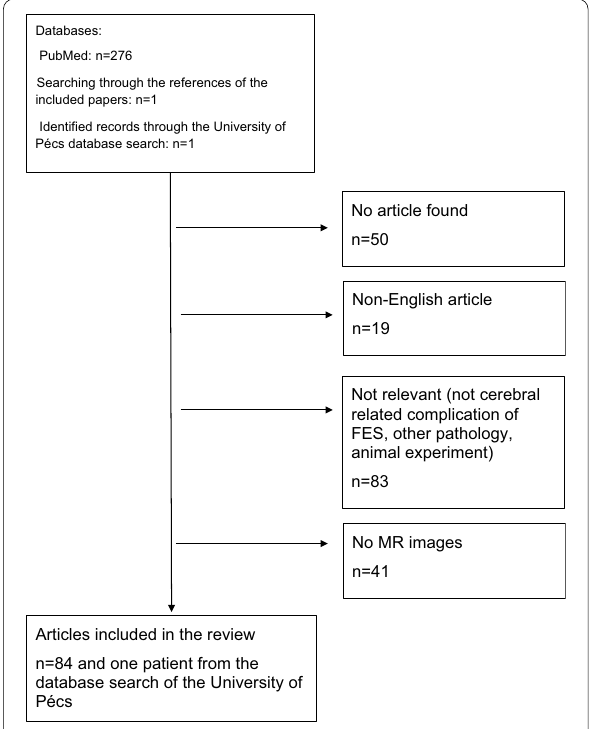
Fig. 1 Quality of Reporting of Meta-analysis standards (QUOROM) flow diagram of articles included in this systematic